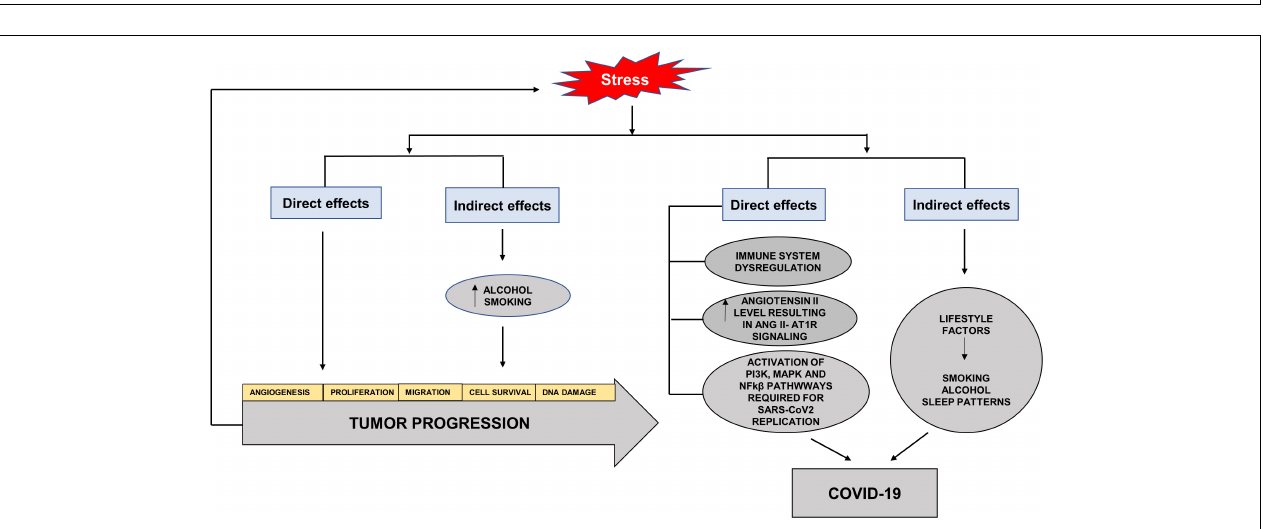
FIGURE 6 | Direct and indirect effects of stress on tumor progression and COVID-19. Stress hormones have direct effects on cancer progression by increasing angiogenesis, cell proliferation, migration, cell survival and DNA damage. The indirect effects of stress may be seen in the adoption of habits such as increased alcohol consumption and cigarette smoking, which aid cancer progression. The direct effects of stress on COVID-19 are through immune dysregulation, increased Angiotensin II levels and activation of pathways required for SARS-CoV2 replication. The indirect effects involve adoption of unhealthy lifestyle factors such as increased alcohol intake, smoking and altered sleep